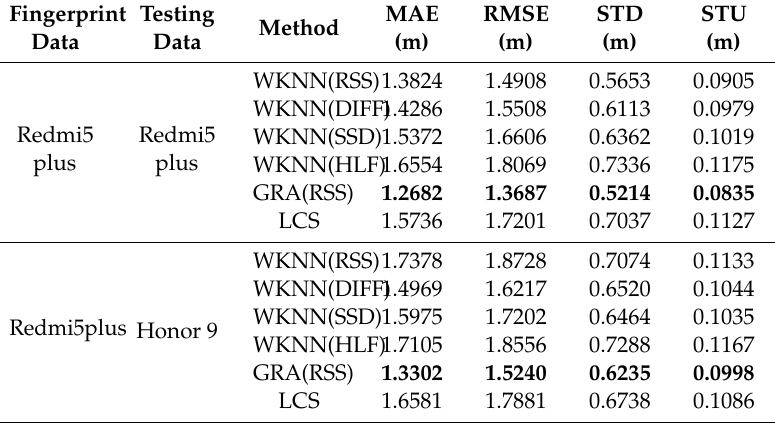
Table 5. Detailed positioning errors for di ff erent methods under heterogeneous and the same